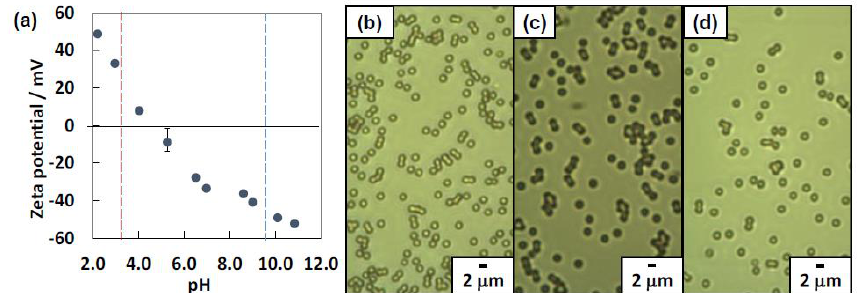
Figure 1. ( a ) Relationship between pH and zeta potential measured for the polystyrene particles carrying amidino and carboxyl groups (ACMPA-PS). ( b – d ) Optical micrographs of aqueous dispersions of ACMPA-PS particles observed at ( b ) pH 2.0, ( c ) pH 4.8 and ( d ) pH 11.1.